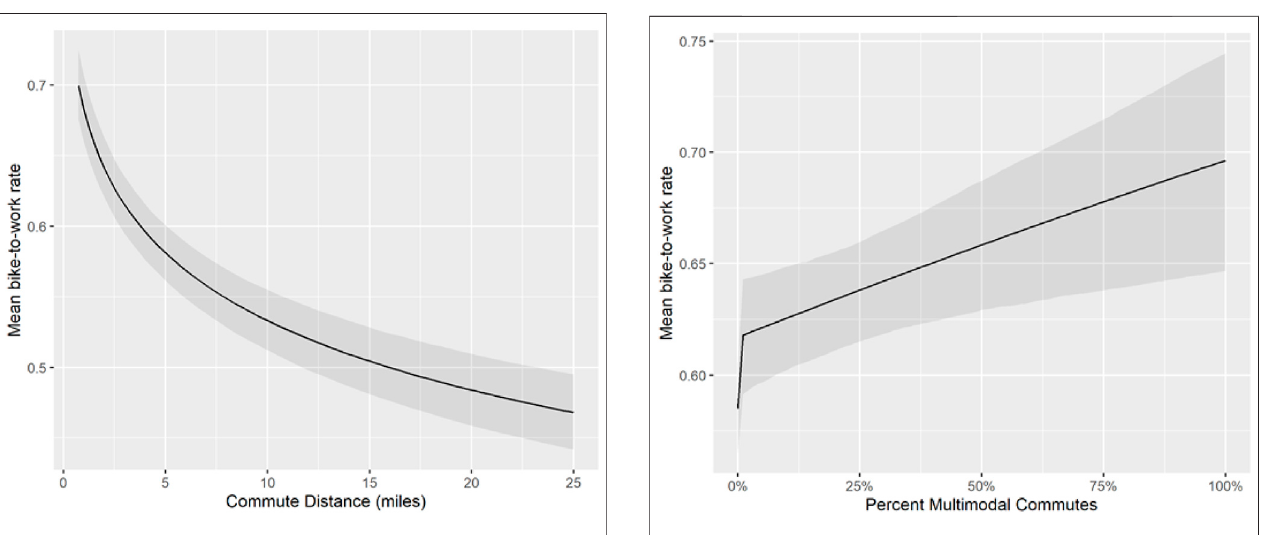
FIGURE 6 | Model predicted mean bike-to-work rate of bike-lending participants by commute distance.